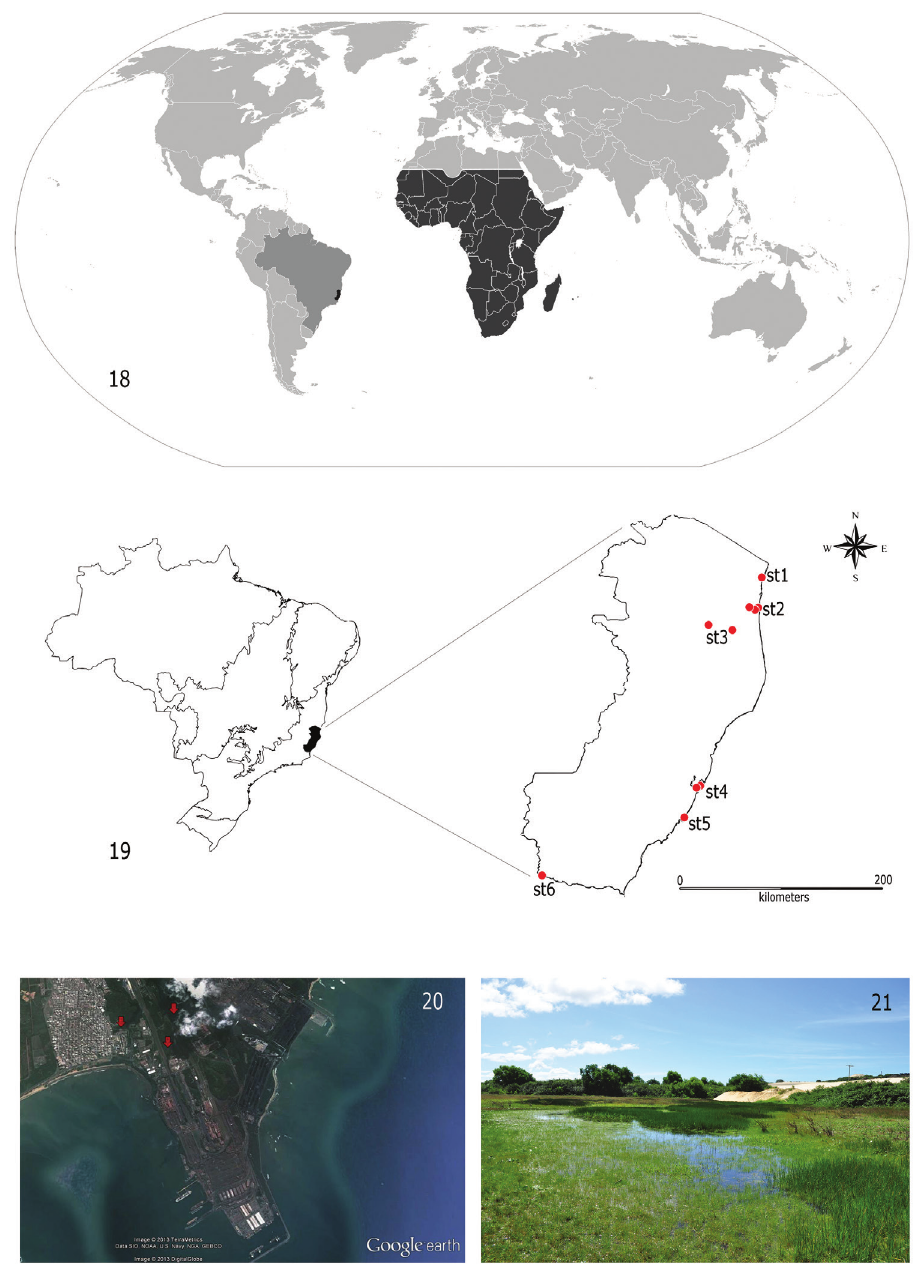
Figures 18–21. Distribution of Cloeon smaeleni . 18 World map (gray, Brazil; dark gray, species distribu- tion) 19 Map of Brazil subdivided in biomes, with detail of the State of Espírito Santo and collection sta- tions (red circles) (st1, Conceição da Barra; st2, São Mateus; st3, Jaguaré; st4, Vitória; st5, Guarapari; st6, Bom Jesus do Norte) 20 Satellite picture from the Tubarão Complex Port in Vitória (red arrows indicate collection stations) 21 General view of one of the stations at Parque Estadual de